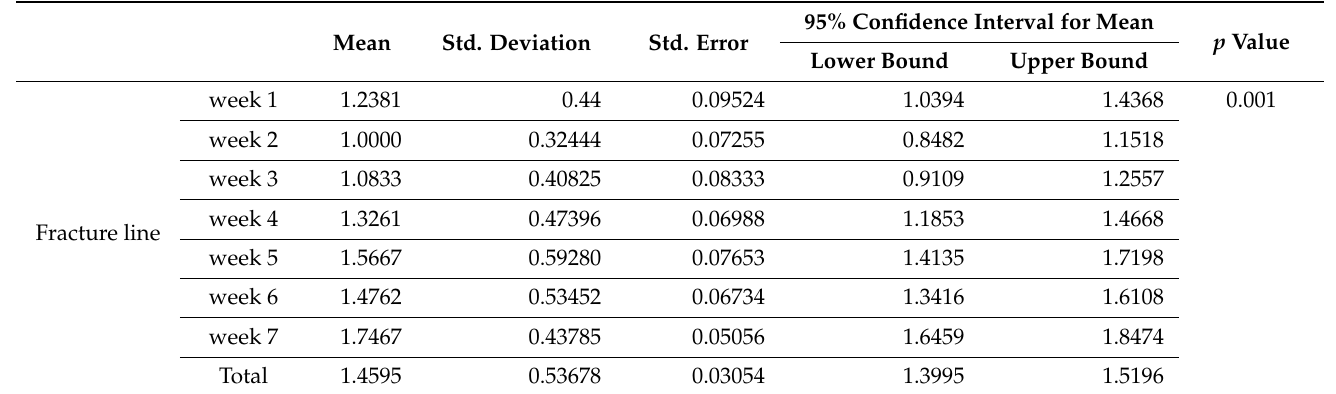
Table A2. Follow-up through the 7 weeks in each of the